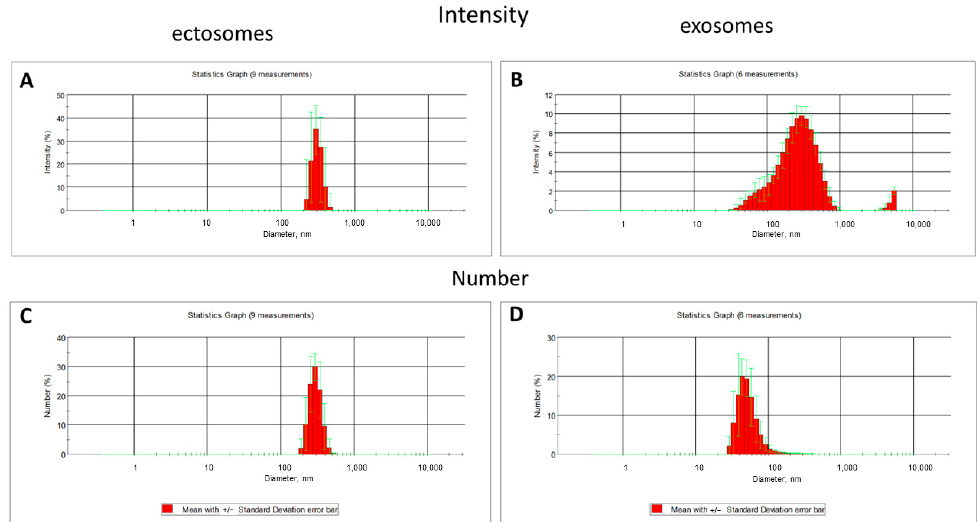
Figure 4. The light scattering intensity ( A , B ) and the numbers of particles ( C , D ) in two fractions of vesicles derived from MSC estimated by dynamic light scattering measurement using a Zetasizer NanoZS.